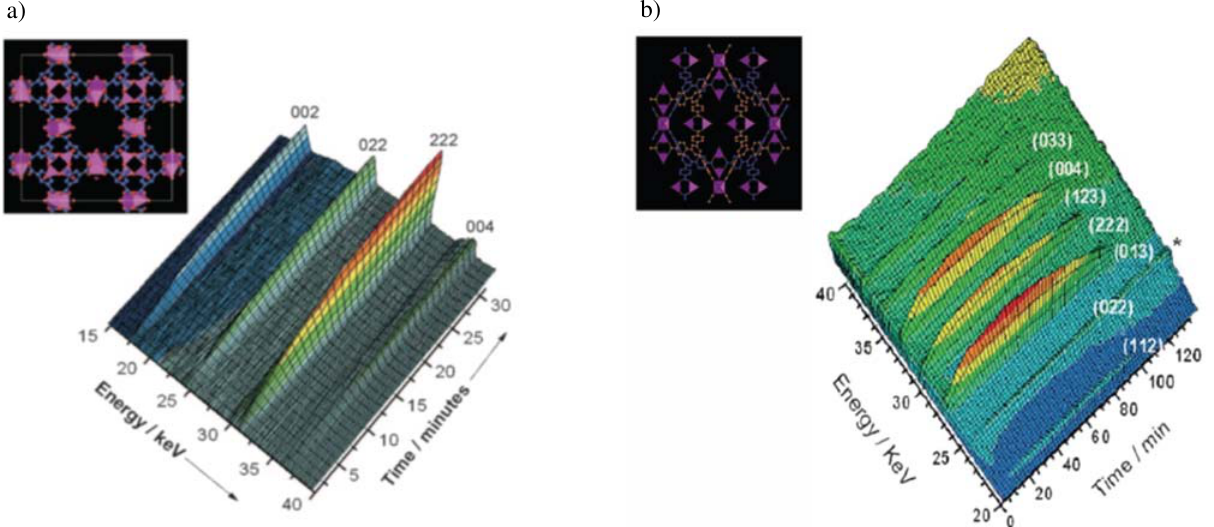
Figure 2. Time-resolved in-situ EDXRD data measured during the crystallization of the (a) copper carboxylate HKUST-1 at 125 °C and (b) MOF- 14 at 130 °C. Insets: view of the structure of HKUST-1 and MOF-14 with five-coordinate Cu-based units as pink polyhedra. 47,48 Reprinted with permission. Copyright Royal Society of Chemistry and John Wiley and